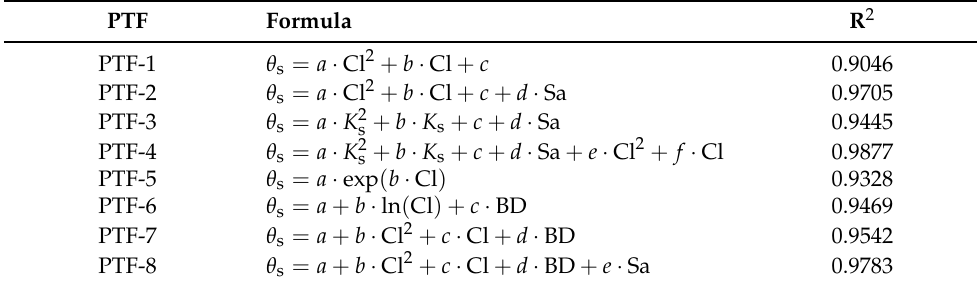
Figure 4. Comparison between the measured θ s and the estimated one by the PTF. The PTF equations are at the top left, and the values for each constant are below that. In addition, the R 2 value and a residual histogram are available. Table 2. New pedotransfer functions.